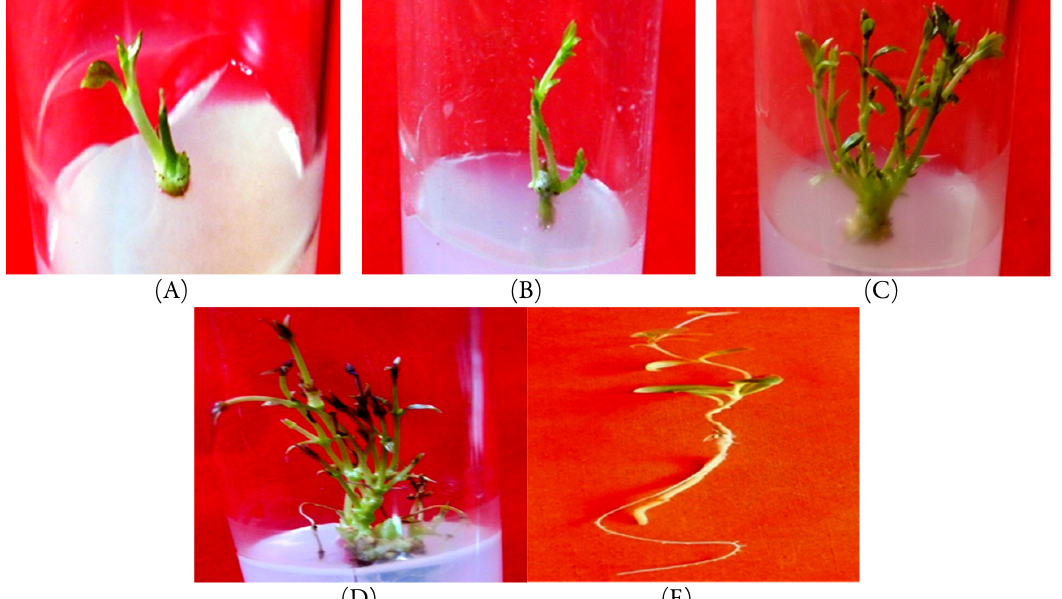
Figure 1. Shoot regeneration from in vitro nodes of H. indicus in MS + sucrose (3%) + BA (10 μM) + Kn (5